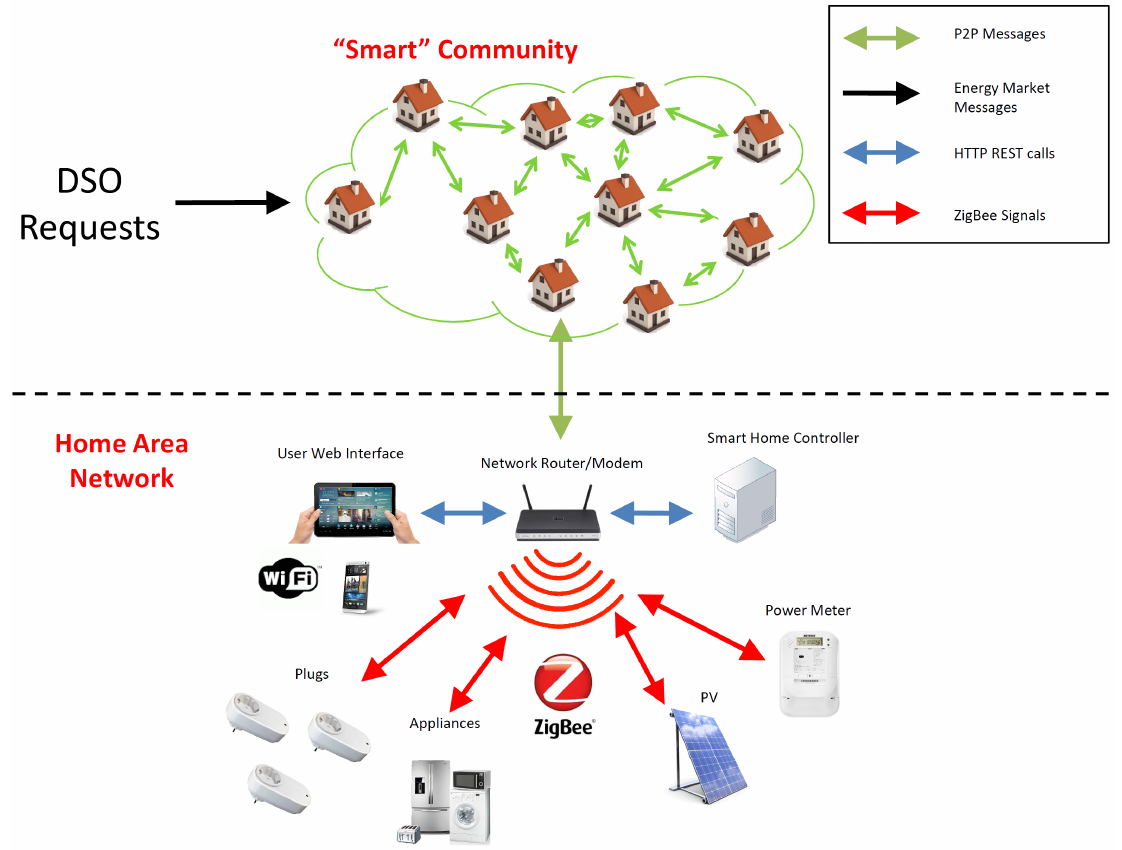
Figure 1. Reference scenario for the